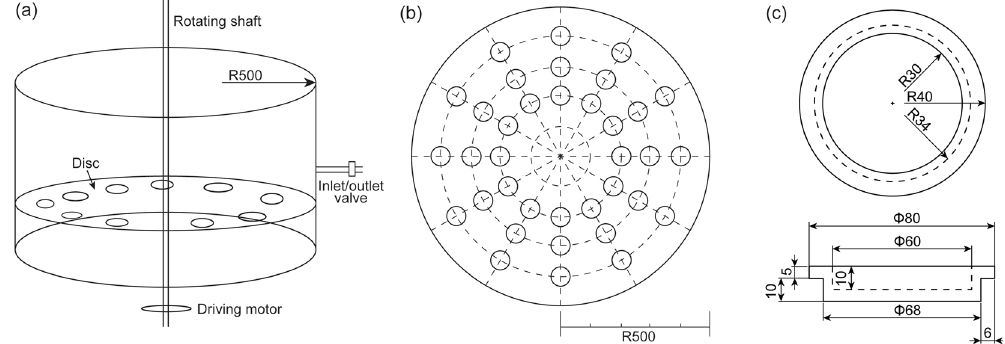
Figure 10. Schematic of the experimental design. ( a ) The reactor and ( b ) the rotating disc with holes arranged for placing ( c ) the sediment containers (unit: